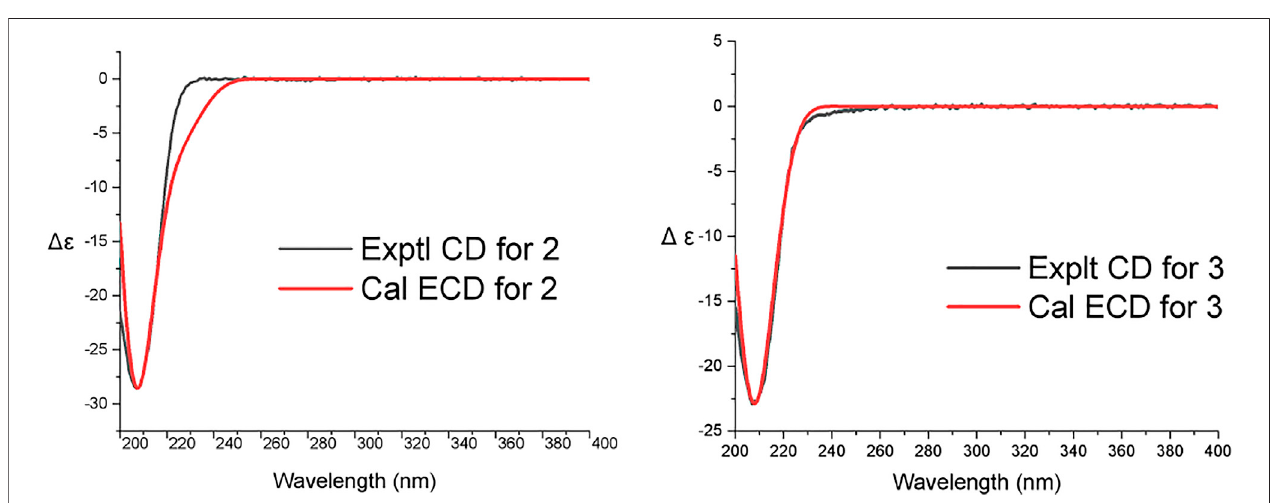
FIGURE 5 | ECD calculation of compound 2 and